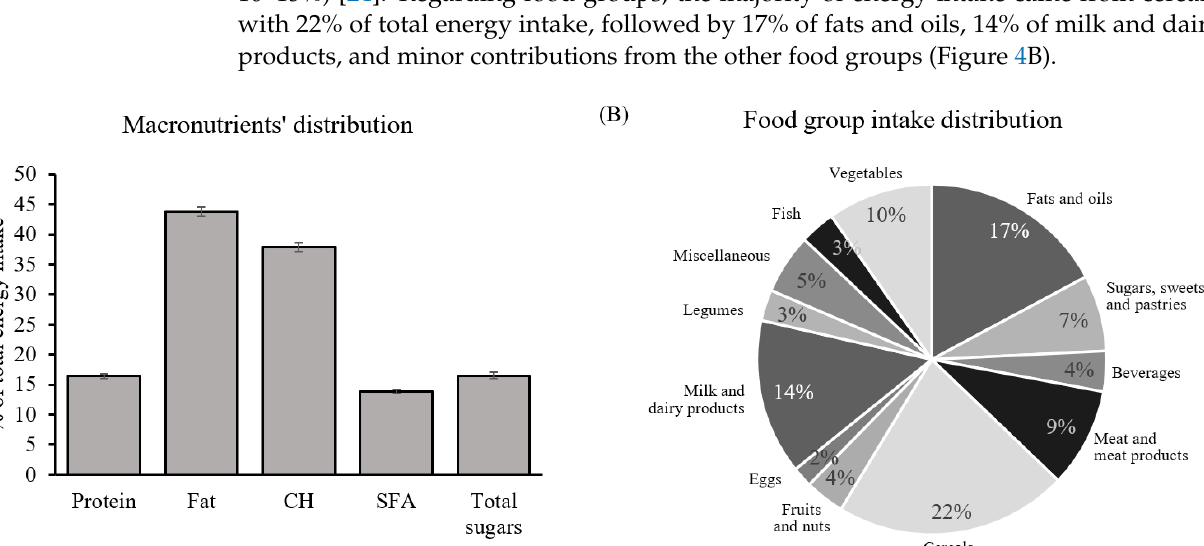
Figure 5. Dietary characterization of the cohort through DPA. ( A ) DPA score distribution; ( B ) BMI of women classified by their DPA score; ( C ) points obtained in each DPA element and classified by